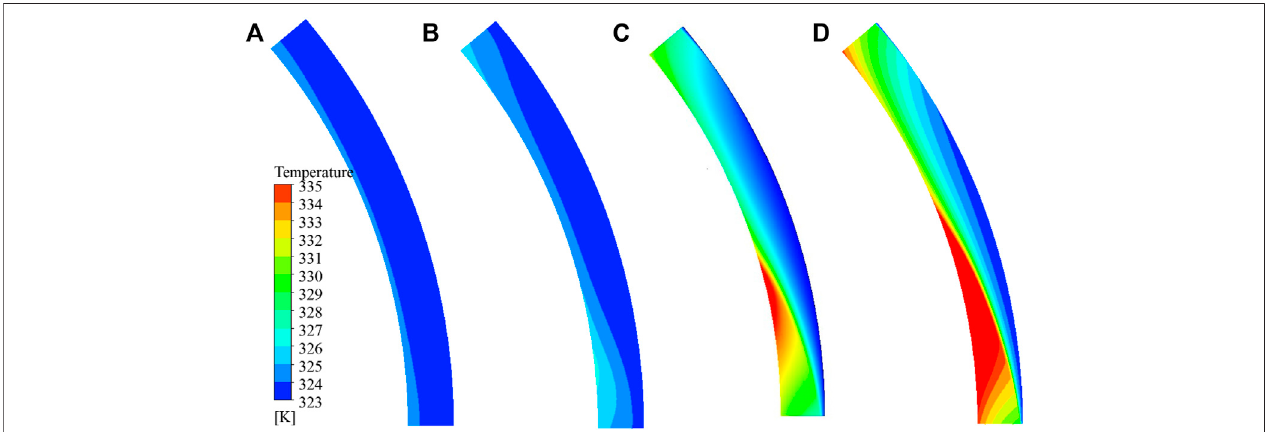
FIGURE 17 | Temperature distribution at different speeds (A) 0 rpm, (B) 500 rpm, (C) 1500 rpm, and (D) 2000 rpm.